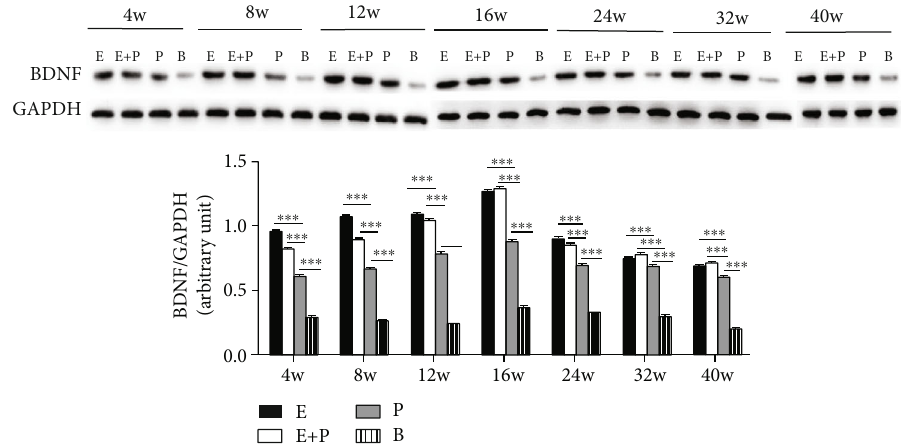
Figure 4: Western blot analysis of BDNF protein levels (normalized to GAPDH) in three groups in the right hemispheres. E: entire root group; E+P: entire root+posterior division group; P: posterior division group; B: blank control group. Data are expressed as mean ± SD ; ∗∗∗ P < 0 : 001 (one-way ANOVA followed by